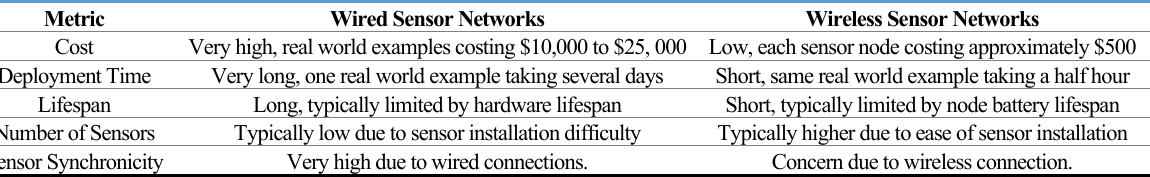
Table 1. Comparison of wired and wireless sensor networks (adapted from Noel et al. [19]). Metric